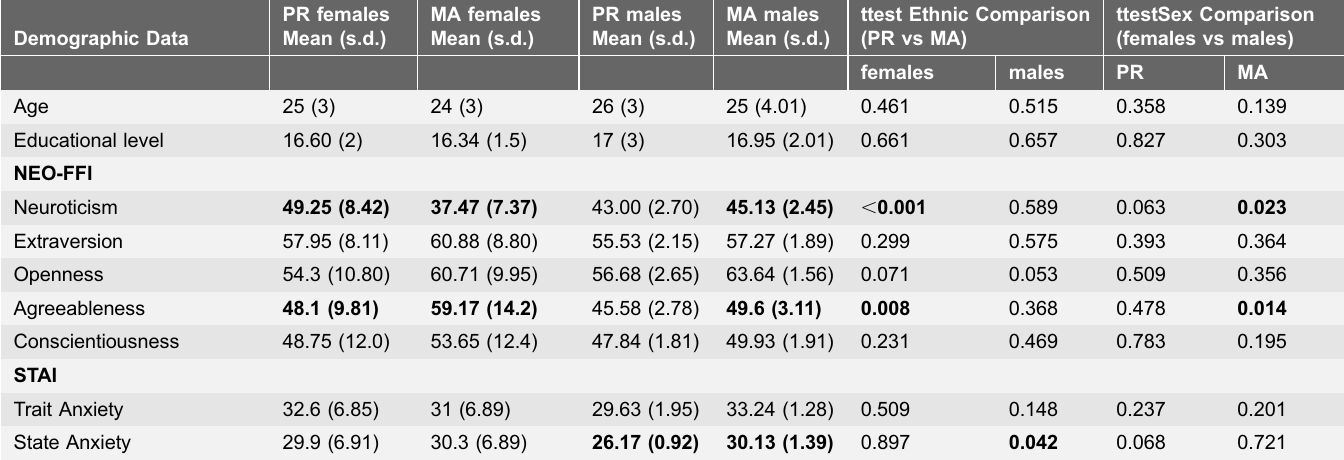
Table 1. Demographics and Psychological Tests Scores of sample divided by sex and site with ttest comparison between PR and MA (ethnic) and between females and males (sex) at each site. Demographic Data